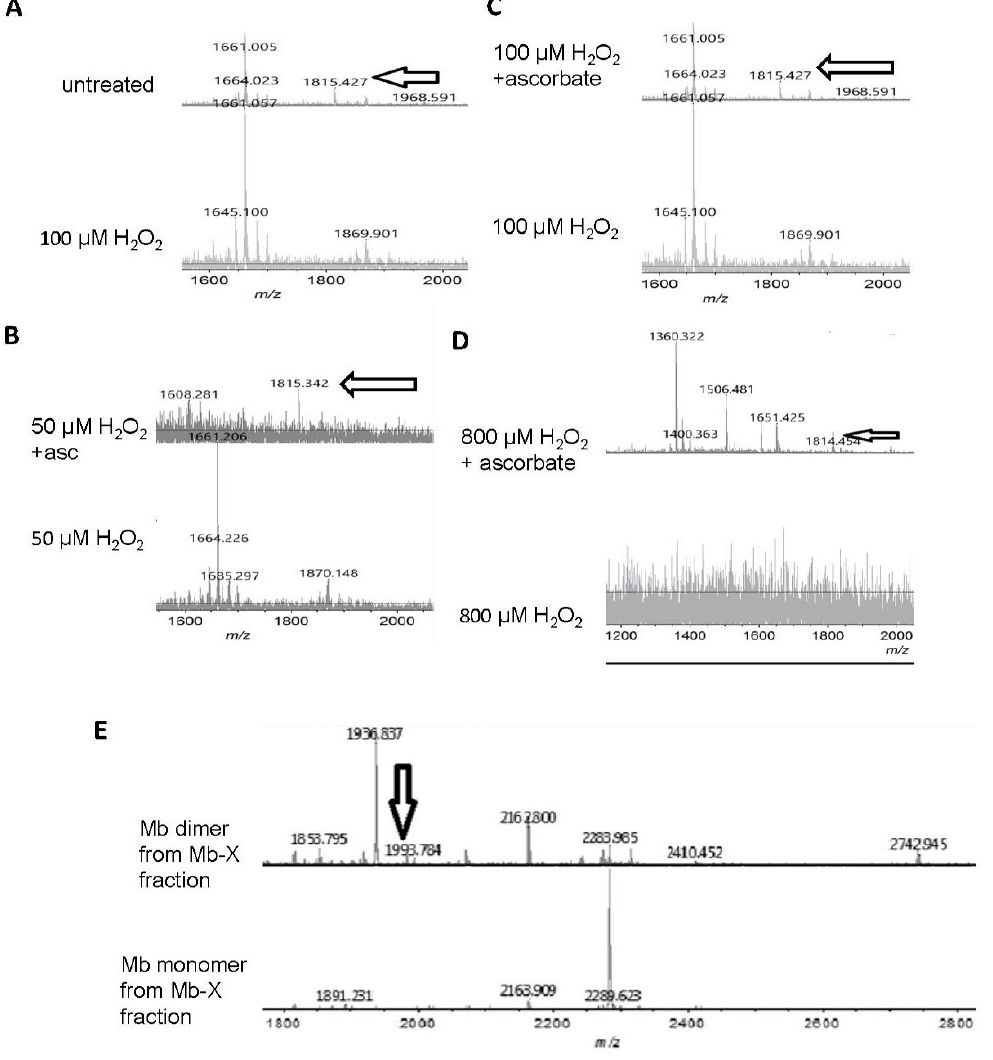
Figure 6. Matrix assisted laser desorption mass spectrometry-time of flight (MALDI-TOF) mass spectrometric analysis of ascorbic acid-mediated reversal of heme-protein crosslinks in H 2 O 2 -reacted metMb. ( A ) (Bottom spectra) MetMb tryptic digests that were reacted with 100 µ M H 2 O 2 displayed loss of the N-terminal peptide (1815.9 m / z ) indicated by arrows in the untreated MetMb (top spectra). ( B – D ) Tryptic digests of H 2 O 2 -reacted metMb that was then treated with ascorbic acid revealed the re-appearance of the N-terminal peptide. ( E ). MetMb monomer (bottom) and dimer (top) tryptic digests that were reacted with 300 µ M H 2 O 2 and analyzed with MALDI-TOF MS. The arrow indicates a peak at 1993 m / z , which suggests presence of a heme crosslinked to a peptide containing the distal histidine of Mb helix E.